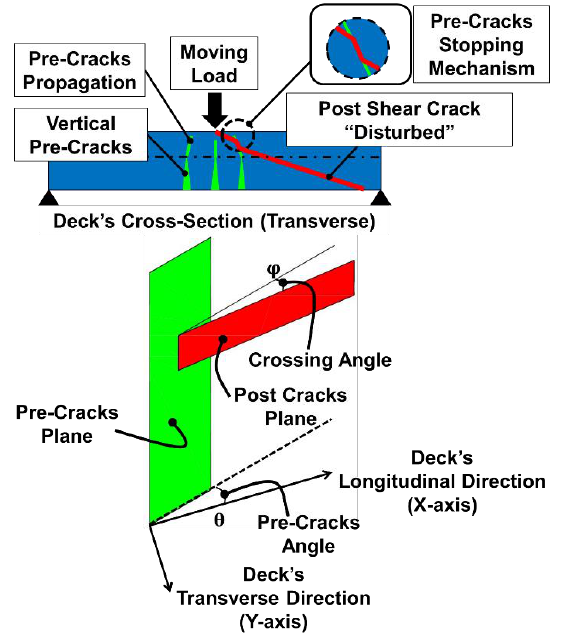
Figure 15. Interaction of pre-cracks and post-shear cracks.